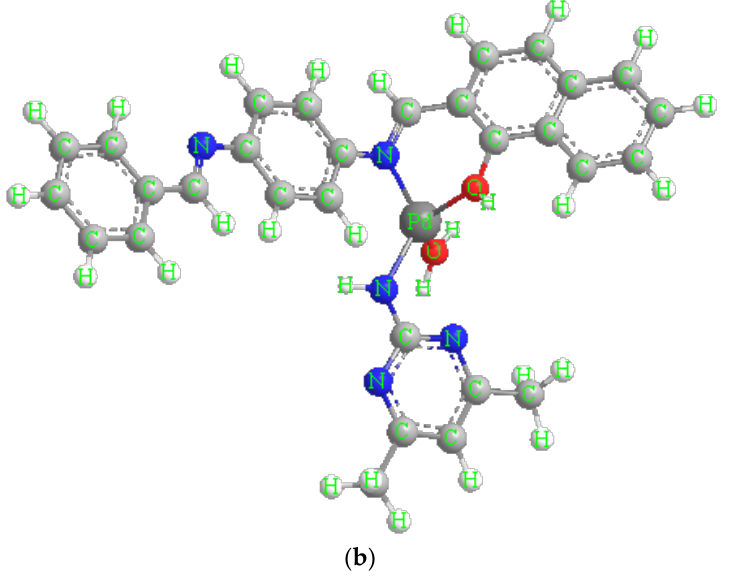
Figure 3. A perspective view of the complete coordination around ( a ) Mn(II) complex. ( b ) Pd(II) complex.